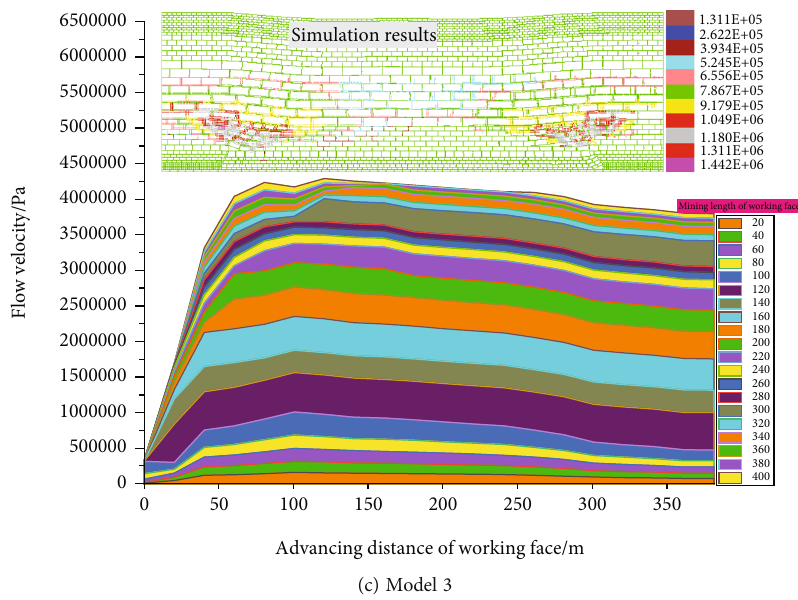
Figure 10: Variation law of water pressure at coal roof with the advancement of working